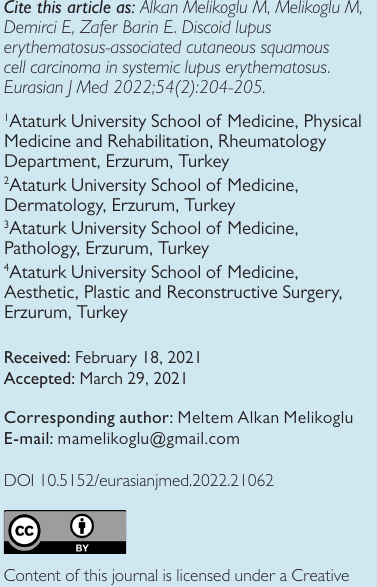
Figure 1. Cutaneous ulcerated lesion over the discoid area on the nose.